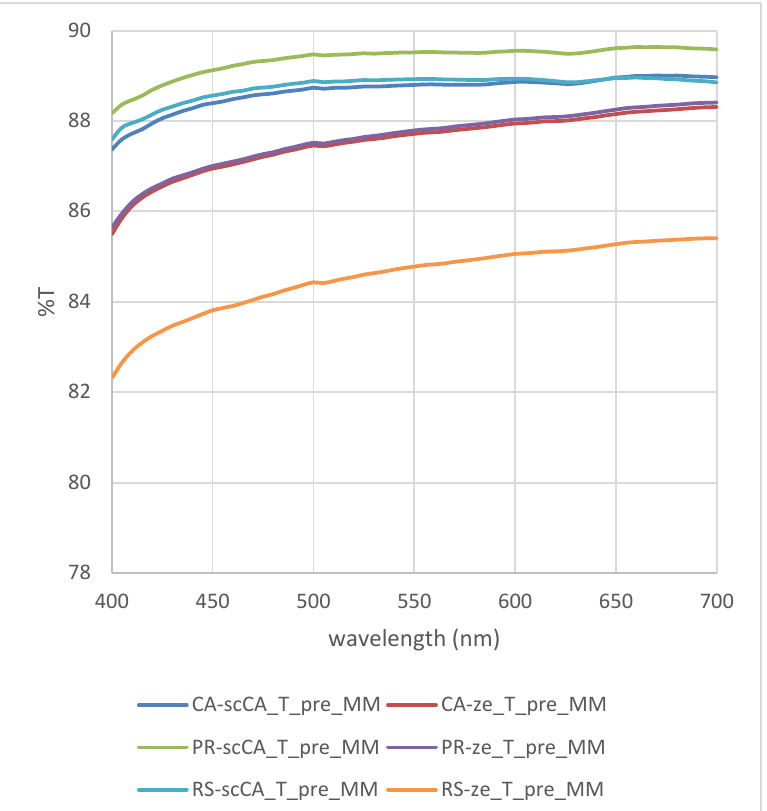
Figure 4. Transmittance curves of all aligners at T0 without SD for better visual clarity.